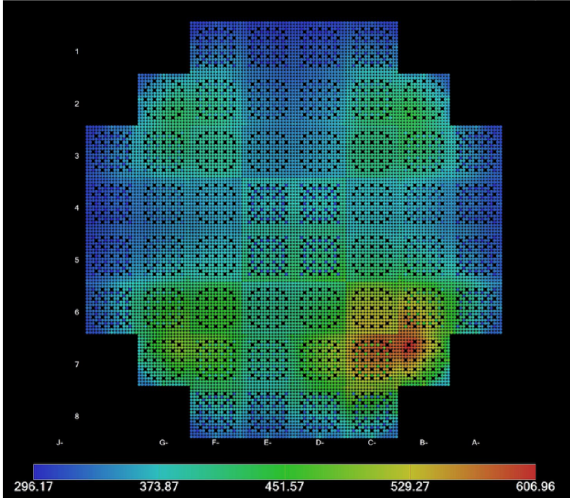
Figure 3: Peak fuel pellet-averaged temperatures ( ◦ C) for the small SBF PWR, with assembly C7 having its RCCA rapidly